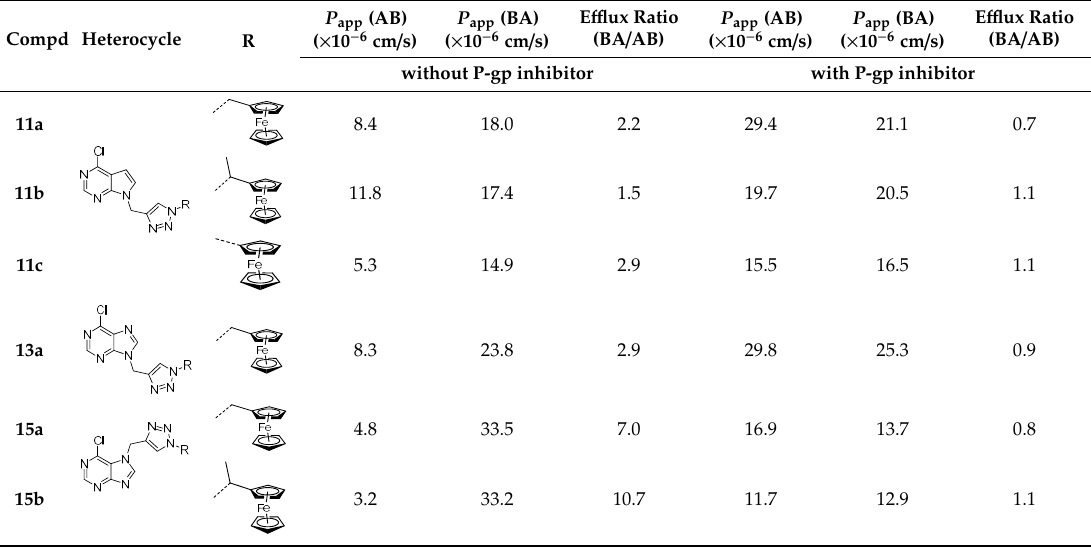
Table 3. Metabolic stability parameters of 11a − 11c , 13a , 15a , 15b in mouse and human liver microsomes.